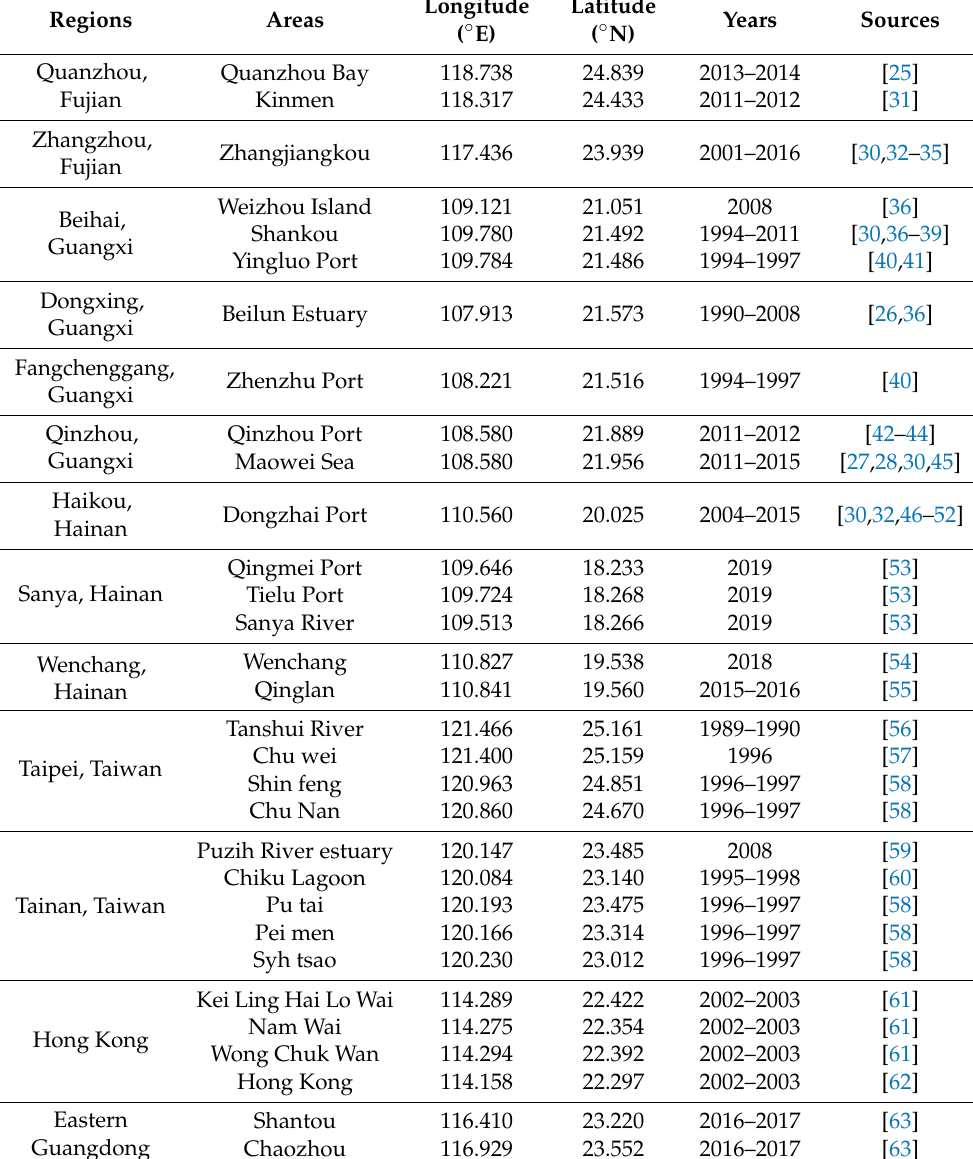
Table 1. Distribution of study